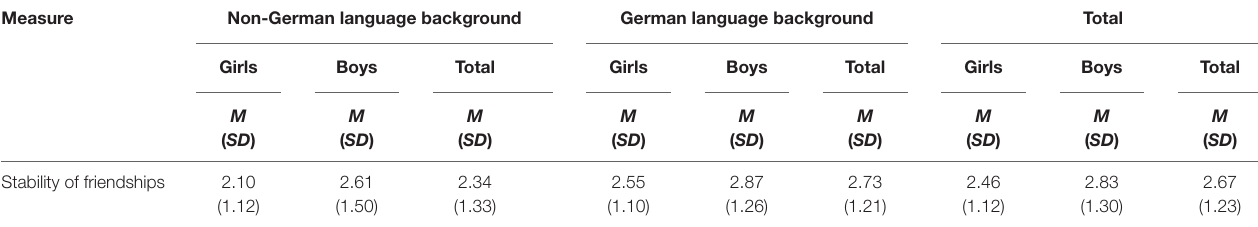
TABLE 7 | Mean values and standard deviations of friendship stability between measurement points I and II. Measure